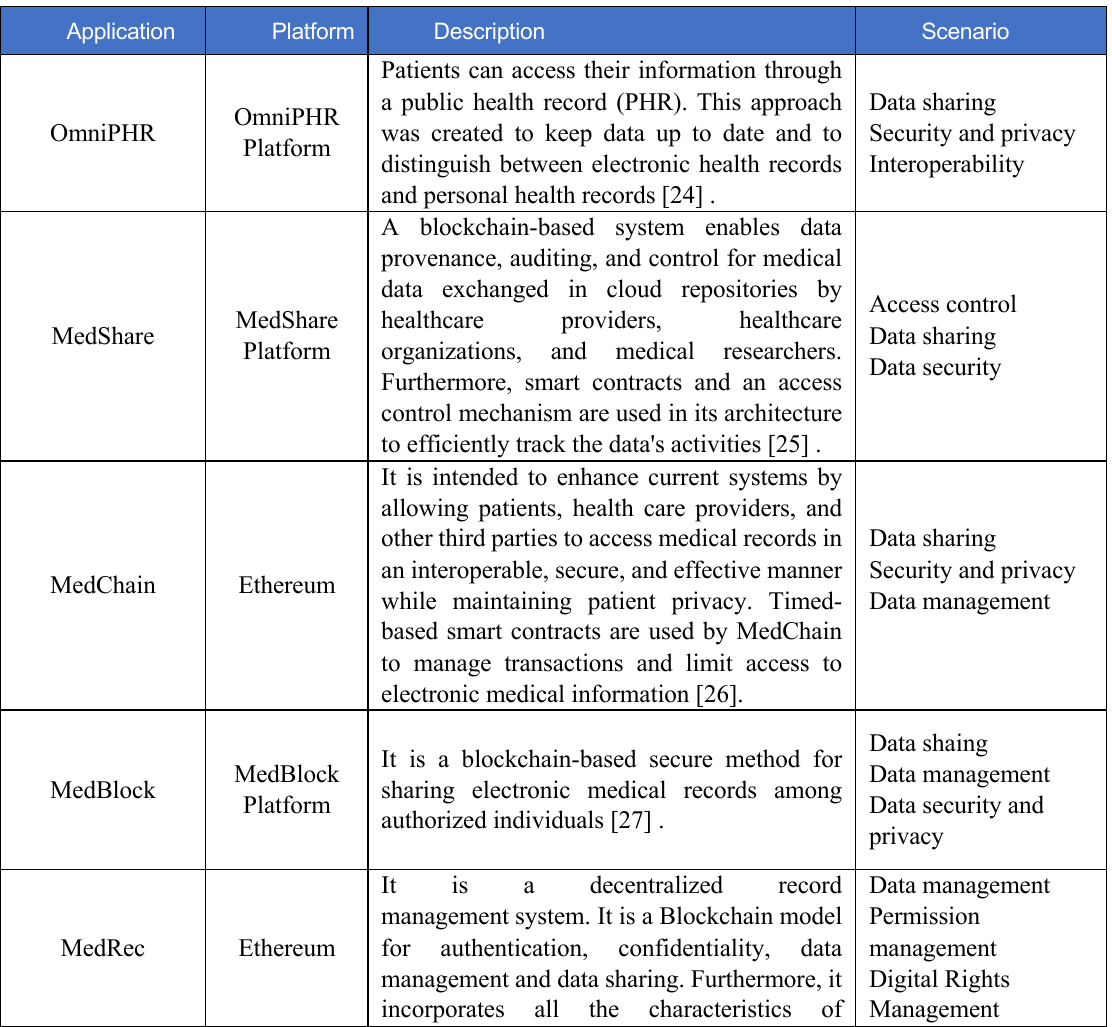
Tableau 1 . Blockchain in healthcare applications Application Platform